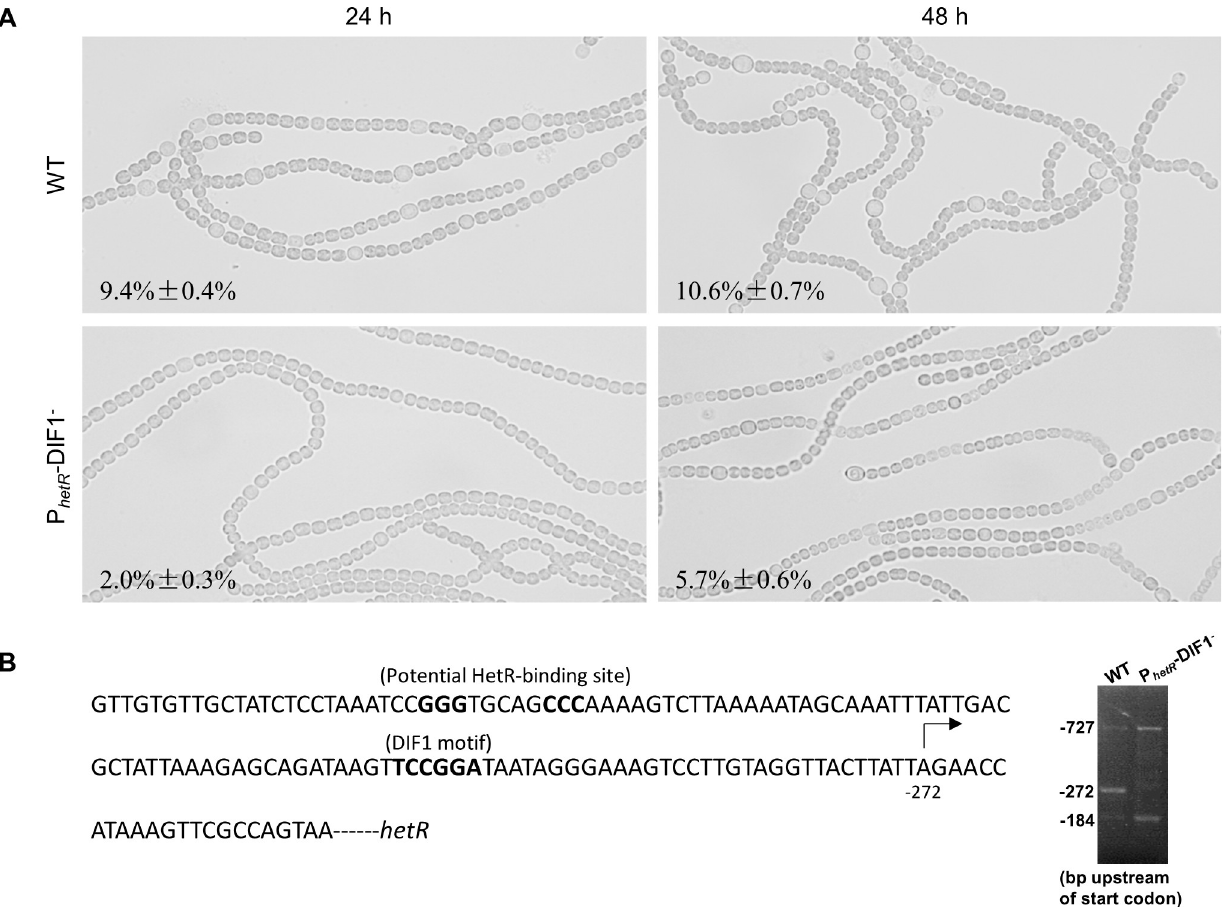
Fig 5. Differences between Anabaena 7120 and the P -DIF1 - strain in heterocyst differentiation and expression of hetR . (A) Photomicrographs of hetR Anabaena 7120 and the P hetR -DIF1 - strain at 24 h and 48 h after nitrogen stepdown. Frequencies of heterocysts/proheterocysts are indicated. (B) A stretch of sequence upstream of hetR , including the DIF1 motif, potential HetR-binding sequence and the tsp at -272 (left), and the electrophoretogram of the 5 0 RACE-PCR products of hetR transcripts in the two strains at 18 h after nitrogen stepdown (right). Each band of the RACE-PCR (indicated with tsp) was confirmed by sequencing.